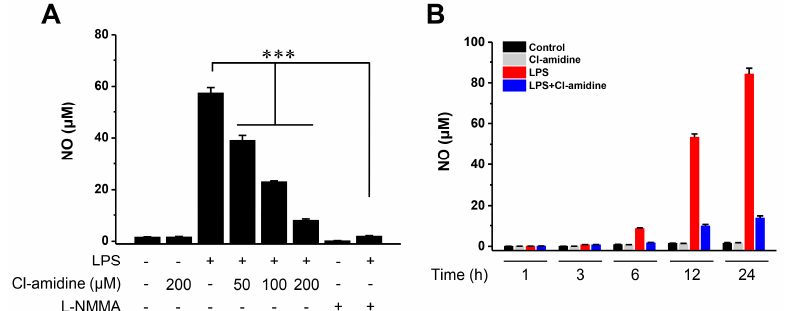
Figure 1. Cl-amidine suppresses nitric oxide (NO) generation in lipopolysaccharide (LPS)-treated dendritic cells (DCs). ( A ) DCs (5 × 10 5 cells) were stimulated with LPS (0.1 μ g/mL), with or without Cl-amidine (50, 100, or 200 μ M), for 24 h. L -NMMA (500 μ M) was used as a positive control for nitric oxide synthase (NOS) inhibition. ( B ) DCs (1 × 10 6 cells) were stimulated with LPS (0.1 μ g/mL), with or without Cl-amidine (200 μ M), for the indicated lengths of time. Quantitative NO levels are represented by bars (mean ± SD; n = 3). *** p < 0.001.